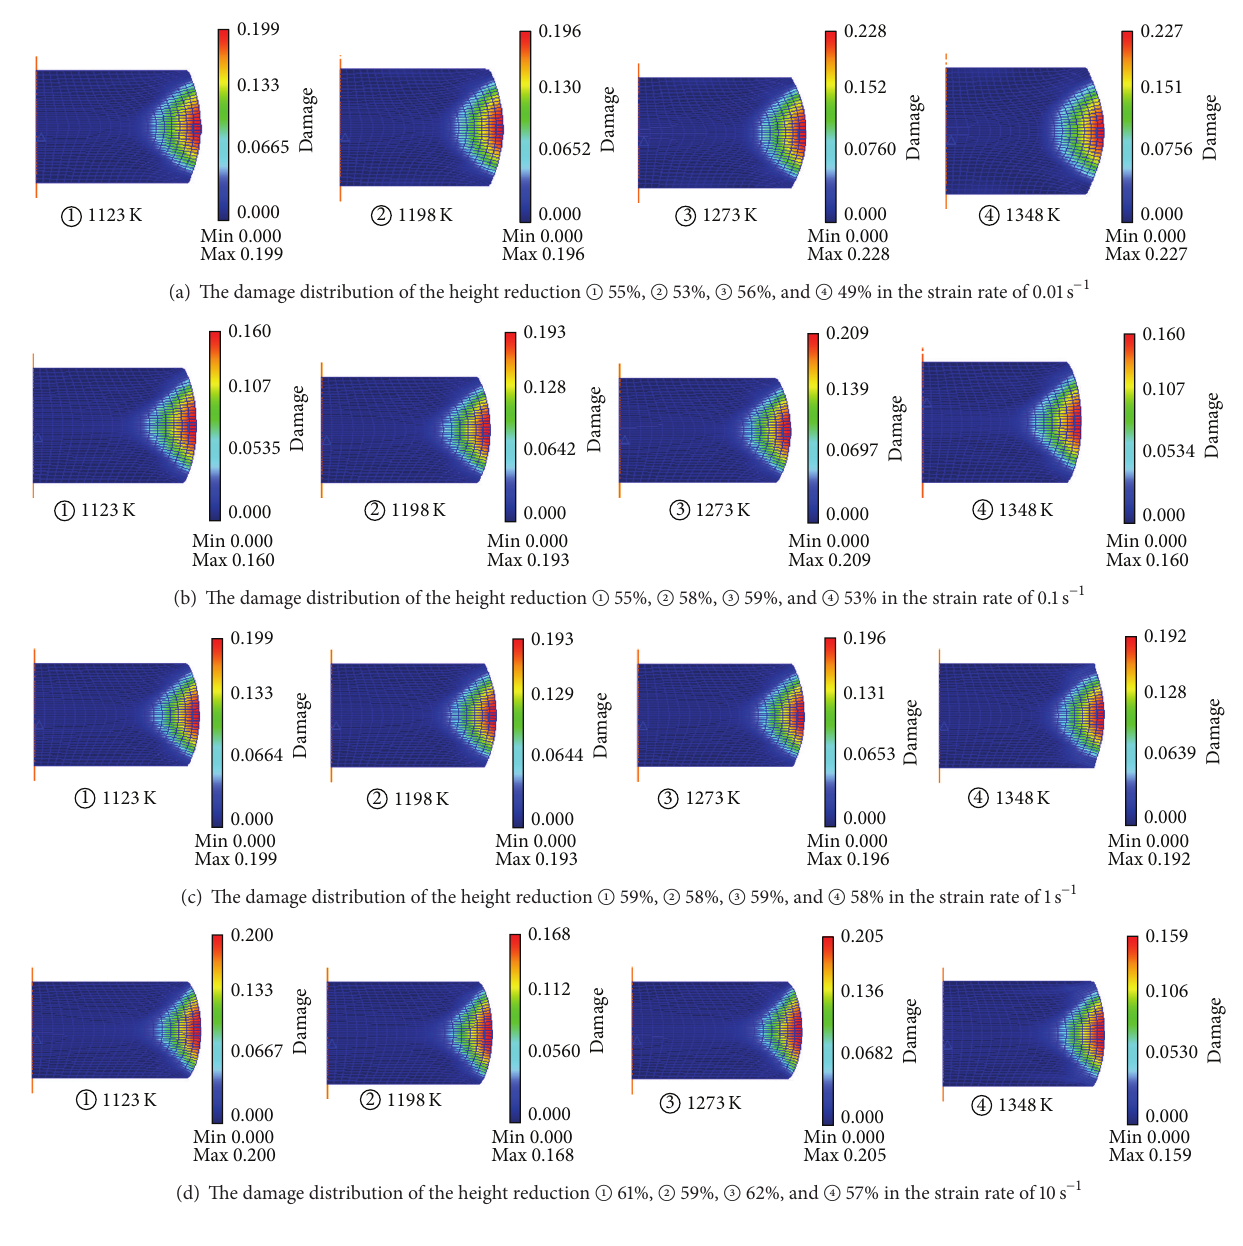
Figure 8: The fracture height reduction and the correspondent DFC under different temperatures and strain rates: (a) 0.01s −1 , 1123 ∼ 1348K; (b) 0.1s −1 , 1123 ∼ 1348K; (c) 1s −1 , 1123 ∼ 1348K; (d) 10 s −1 , 1123 ∼ 1348